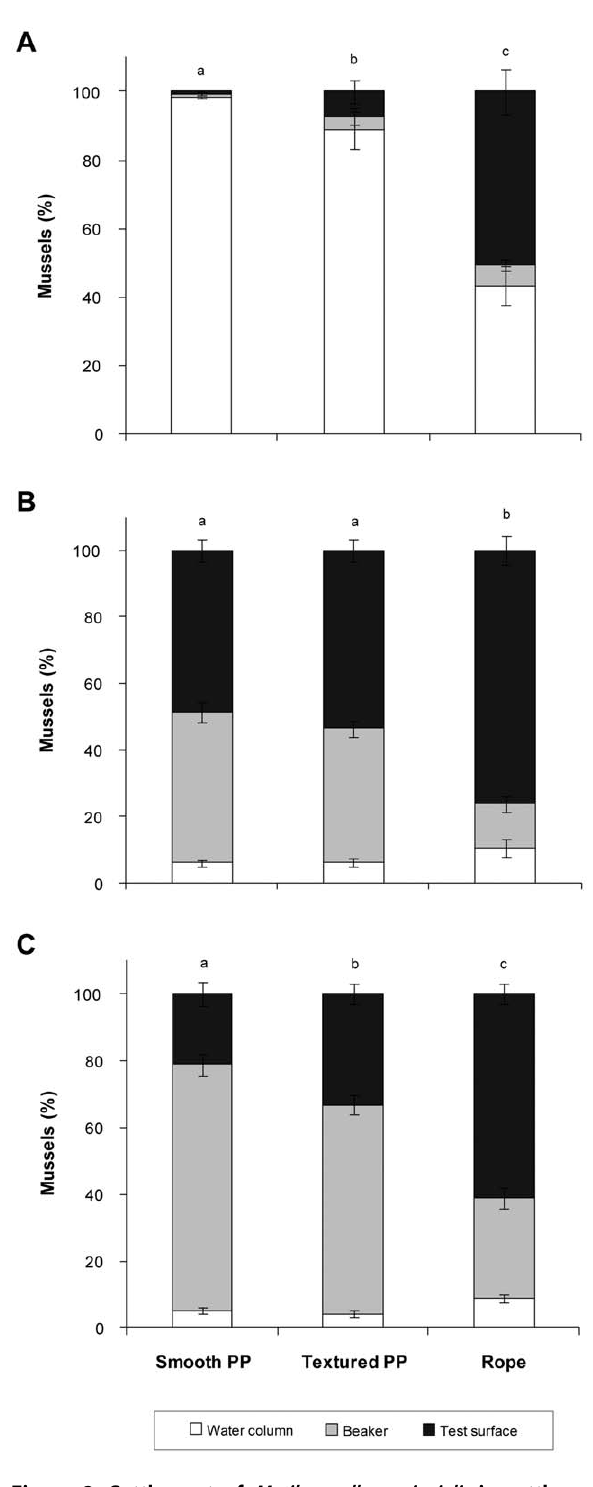
Figure 2. Settlement of Mytilusgalloprovincialis in settlement assays with no choice between polypropylene (PP) surfaces. Number of mussels (%) settled on test surfaces (smooth PP, textured PP, rope) and glass beaker and suspended in the water column after 48 h. Settlement assays were conducted with mussels (A) 22 days, (B) 30 days, and (C) 38 days post fertilisation. Means 6 SE are shown ( n =10). Superscript letters indicate significant differences between test surfaces (pair-wise a posterior test, a